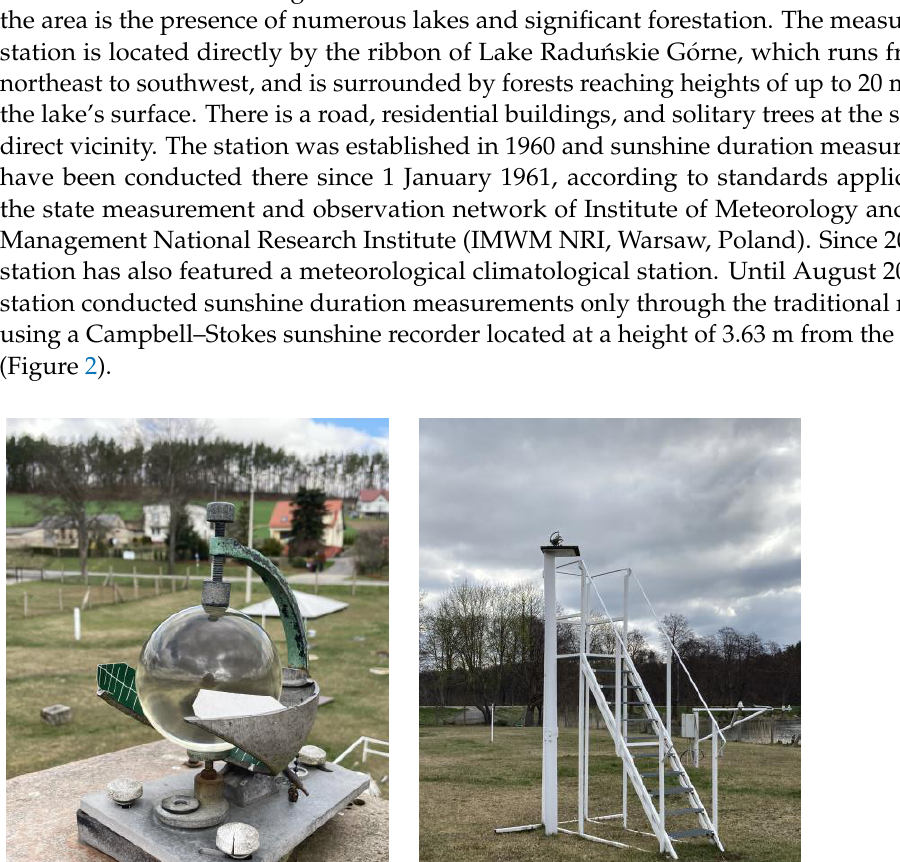
Figure 1. Location of Borucino Limnological Station.